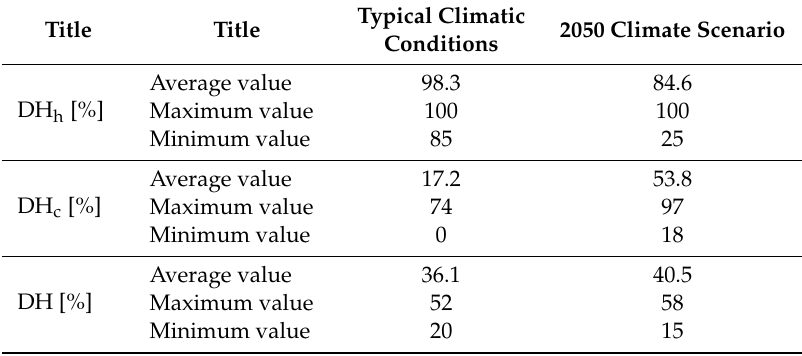
Figure 7. Distribution of DH values in the building category during a whole year: ( a ) under typical climatic conditions; ( b ) for the 2050 climate scenario. Table 4. Main results of the environmental assessment of the building category.